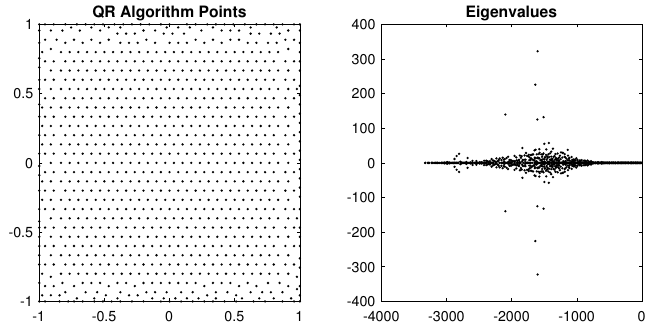
Figure 14. Resulting points for a 19-point stencil with Dirichlet Laplacian eigenvalues. These points were obtained by iteratively applying the MCpQR algorithm for smaller